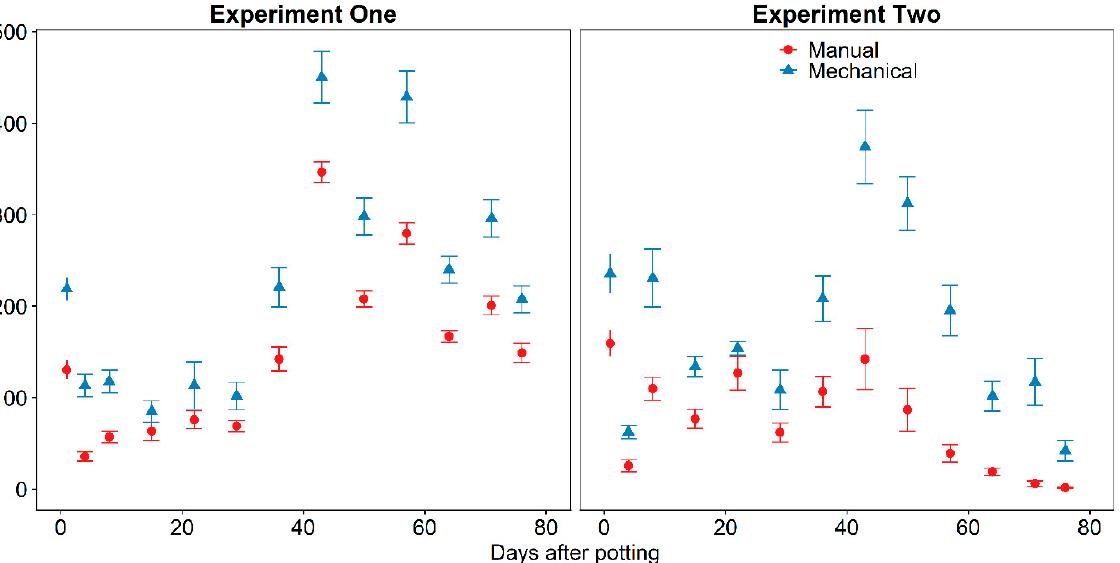
Figure 6. Nitrate-nitrogen leached from unplanted (Experiment One) or planted (Experiment Two) Douglas fir bark substrate and with either manually or mechanically incorporated Osmocote Plus 15-9-12 controlled-release fertilizer. Error bars are standard error ( n = 10) of the mean.